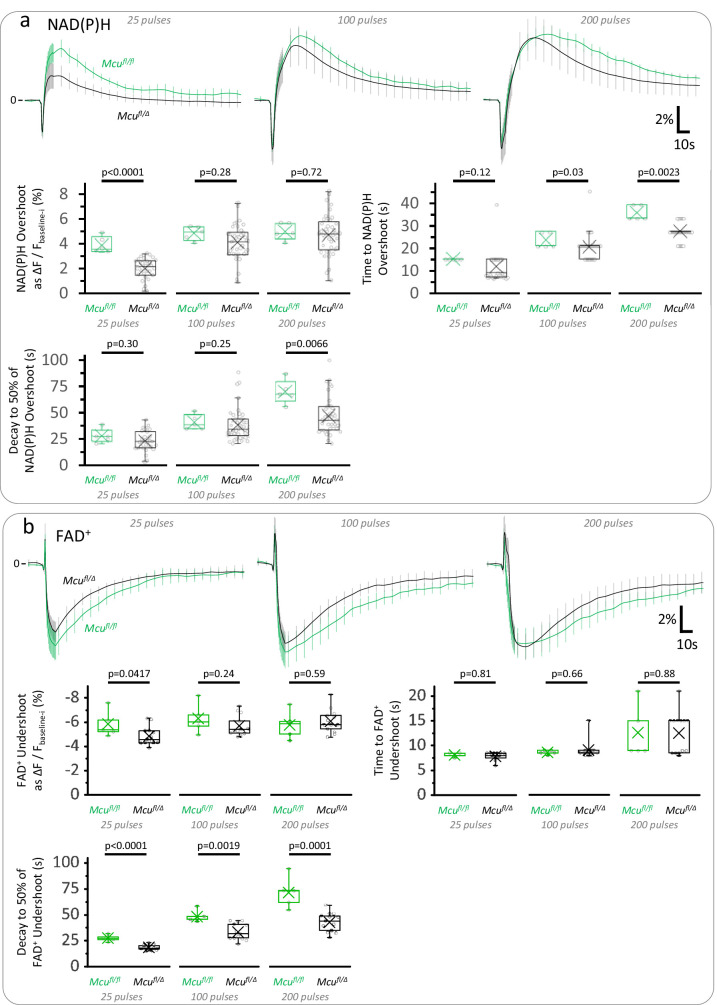
Hemizygous mice for MCU show mild impairments in the TCA cycle with respect to Mcufl/fl controls.(a) Average traces of the NAD(P)H signal expressed as the ΔF/Fbaseline-i ratio (mean ± SD of number of slices, sample sizes for Mcufl/Δ mice as in Figure 3b, Right panel; sample size for Mcufl/fl: Nslices = 5, Nmice = 3). Depending on the stimulation paradigm, the magnitude and/or duration of the late overshoot were diminished in Mcufl/Δ mice when compared to Mcufl/fl controls. (b) Average traces of the FAD+ signal expressed as the ΔF/Fbaseline-i ratio (mean ± SD of number of slices, sample sizes for Mcufl/Δ mice as in Figure 3—figure supplement 3). The late FAD+ undershoot was less affected by the deletion of one Mcu allele, although its duration was still shortened in Mcufl/Δ mice when compared to Mcufl/fl controls. A Student’s t test or a Welch’s t-test were used for comparisons between normally distributed data, or a non-parametric Mann-Whitney test was used otherwise.